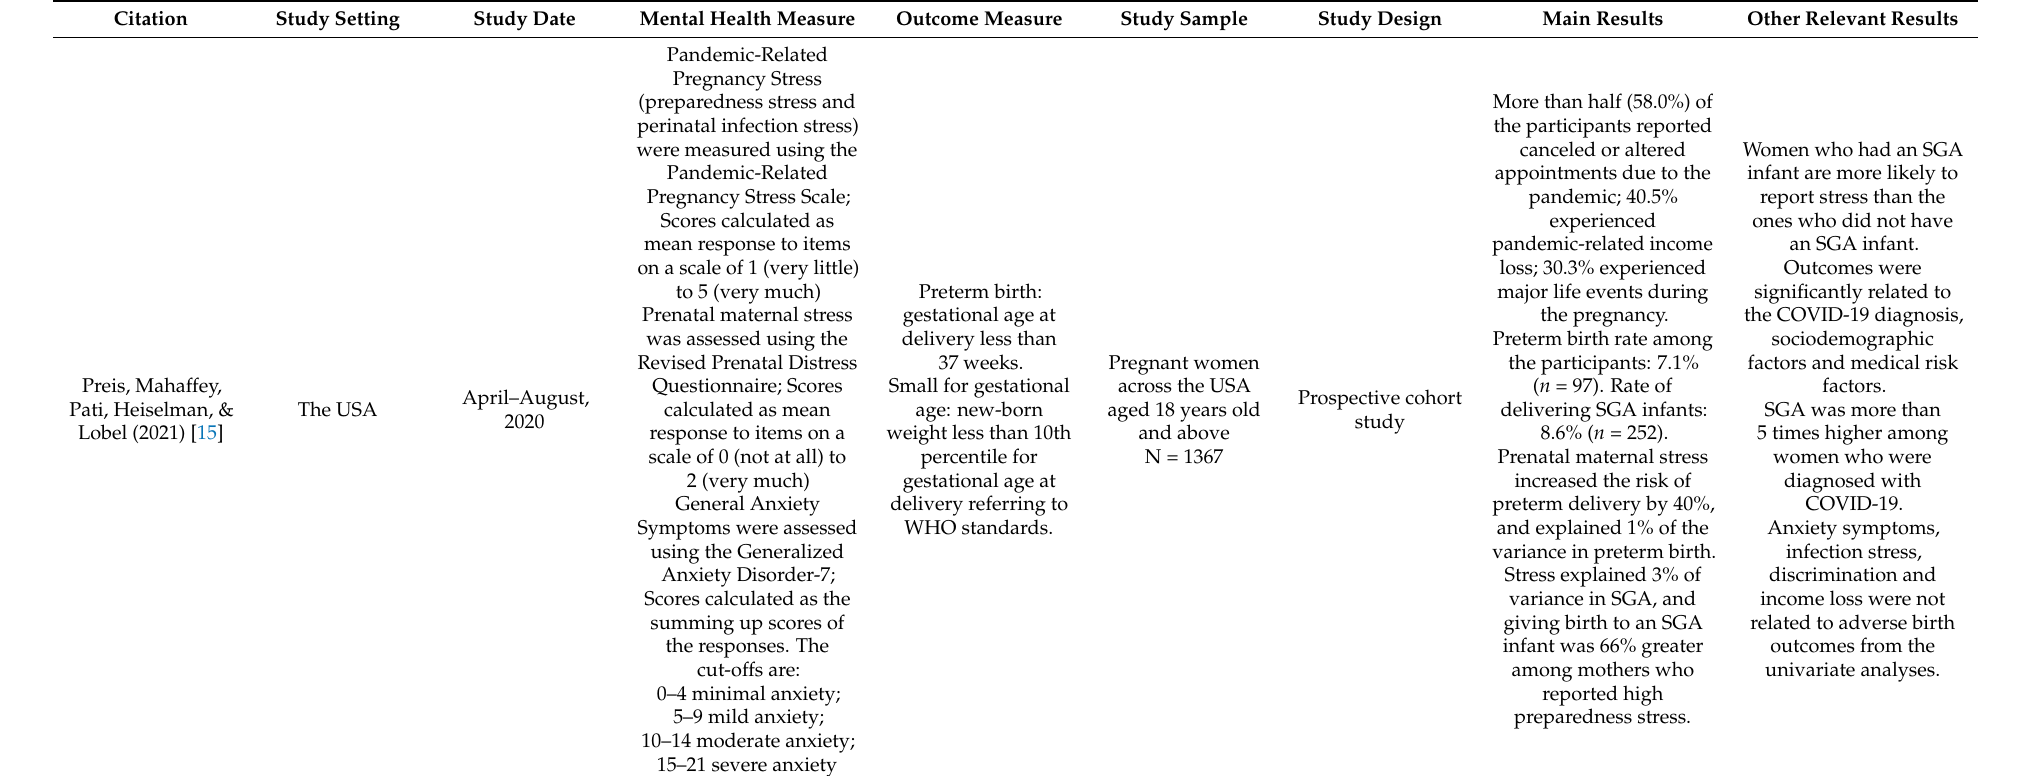
Table 1. Study characteristics of the included